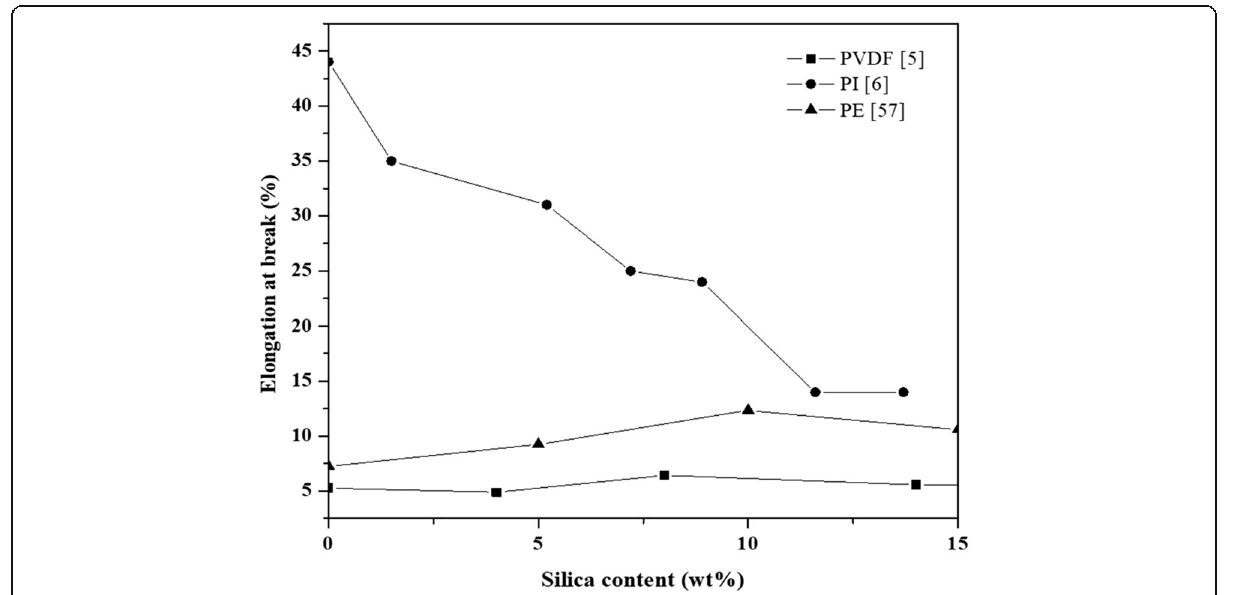
Fig. 13 Elongation at break of MMMs containing silica (PVDF: polyvinylidene fluoride; PI: polyimide; PE: